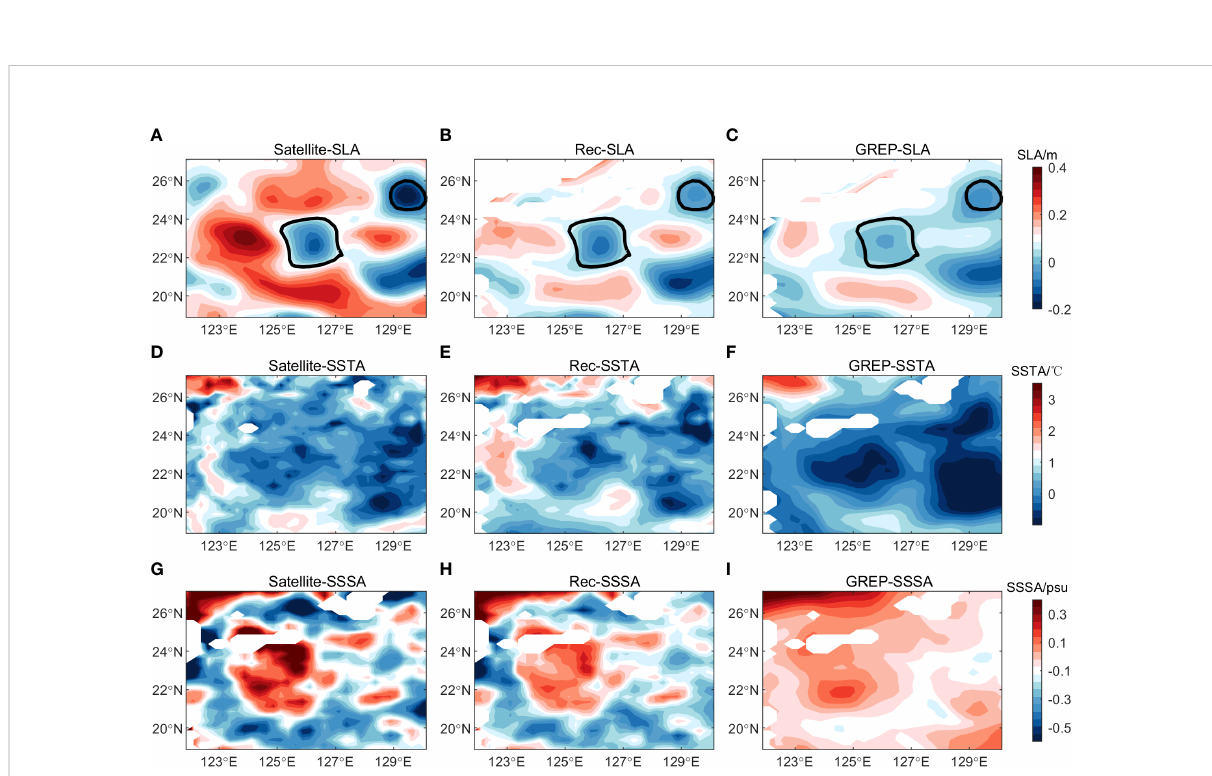
FIGURE 5 The distribution of the anomaly fi elds of sea surface level, temperature and salinity from satellite, synthetic fi elds and GREP reanalysis data on May 13, 2019. (A, D, G) the SLA, SSTA, and SSSA of the satellite observations, (B, E, H) the SLA, SSTA, and SSSA of the synthetic fi elds, (C, F, I) the SLA, SSTA, and SSSA of the GREP reanalysis